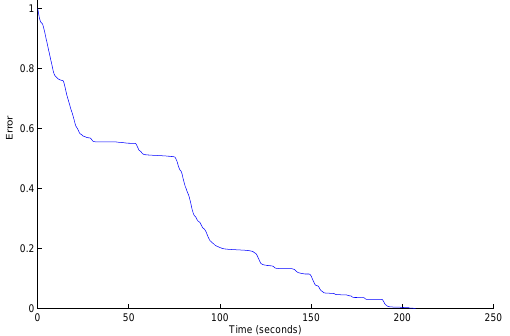
Table 2. Table of pairwise simulation parameters. Robot Robot Obs.